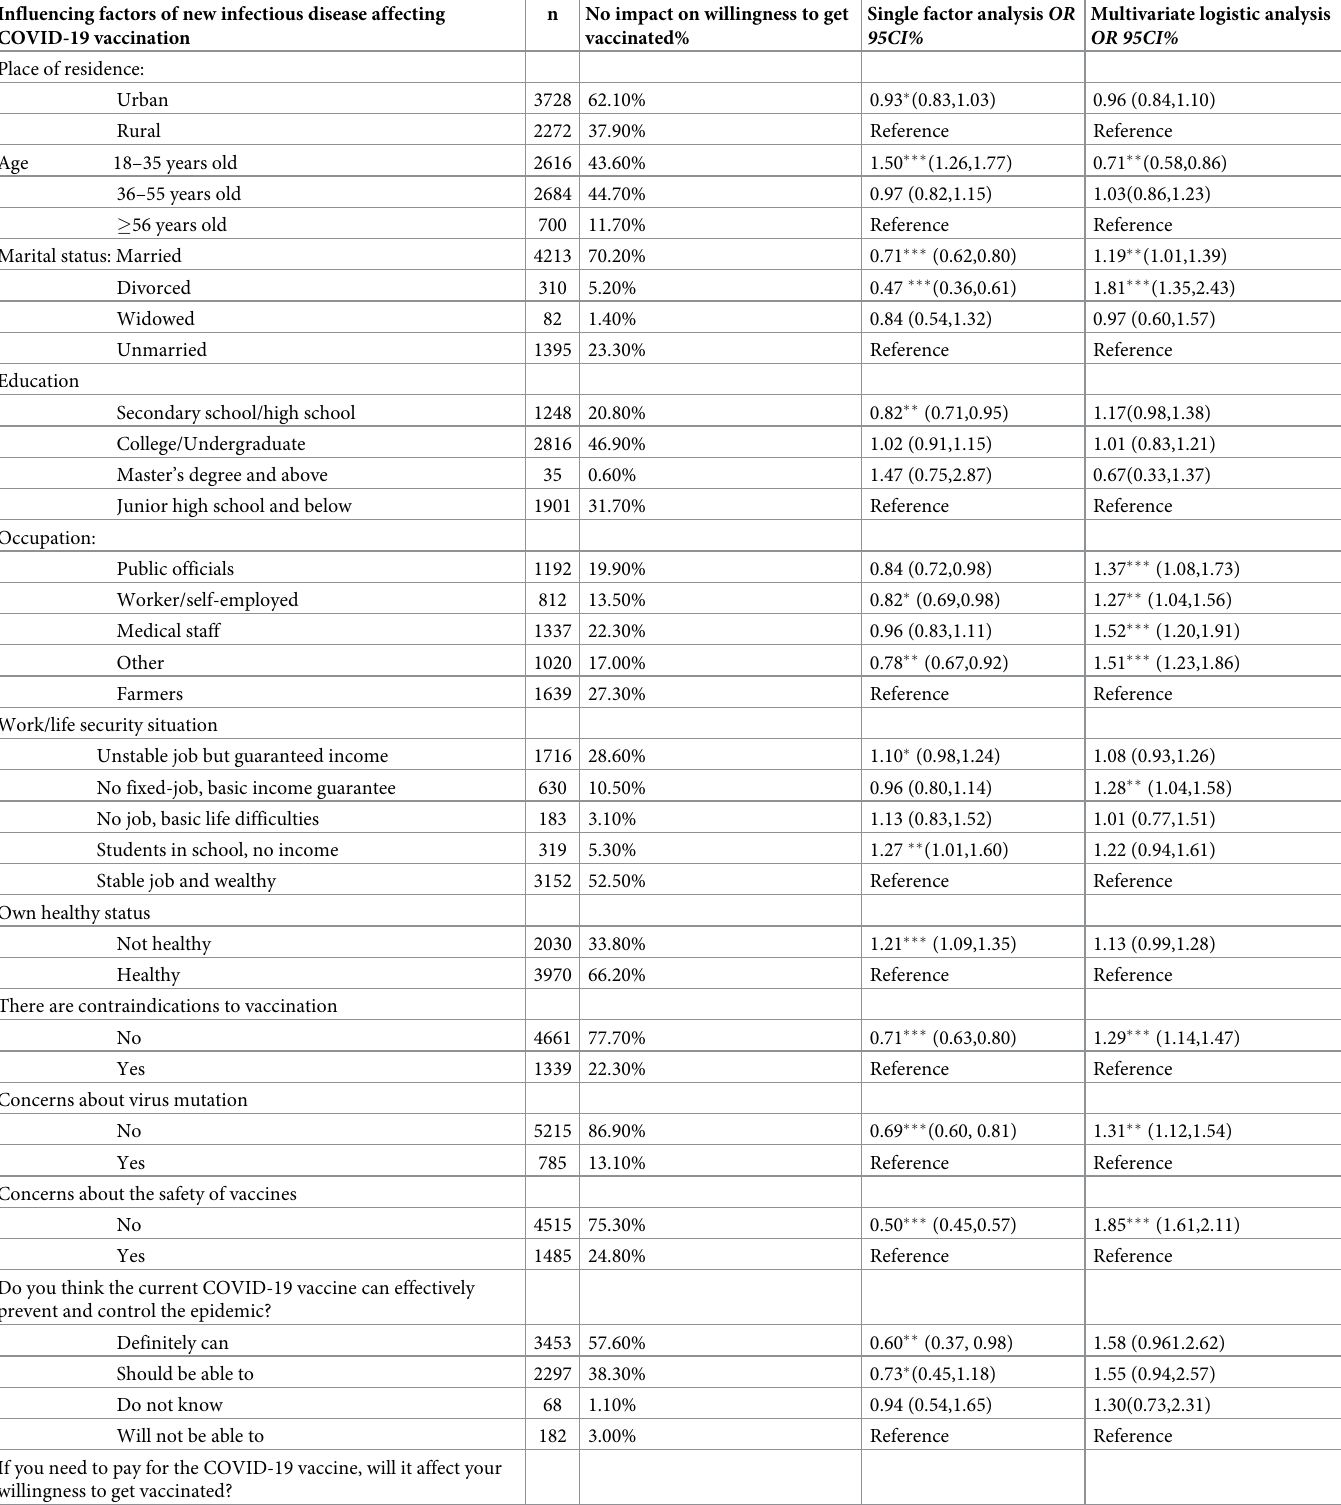
Table 4. The impact factors of new COVID-19 epidemic on vaccination willingness with logistic regression analysis (n = 6000). Influencing factors of new infectious disease affecting COVID-19